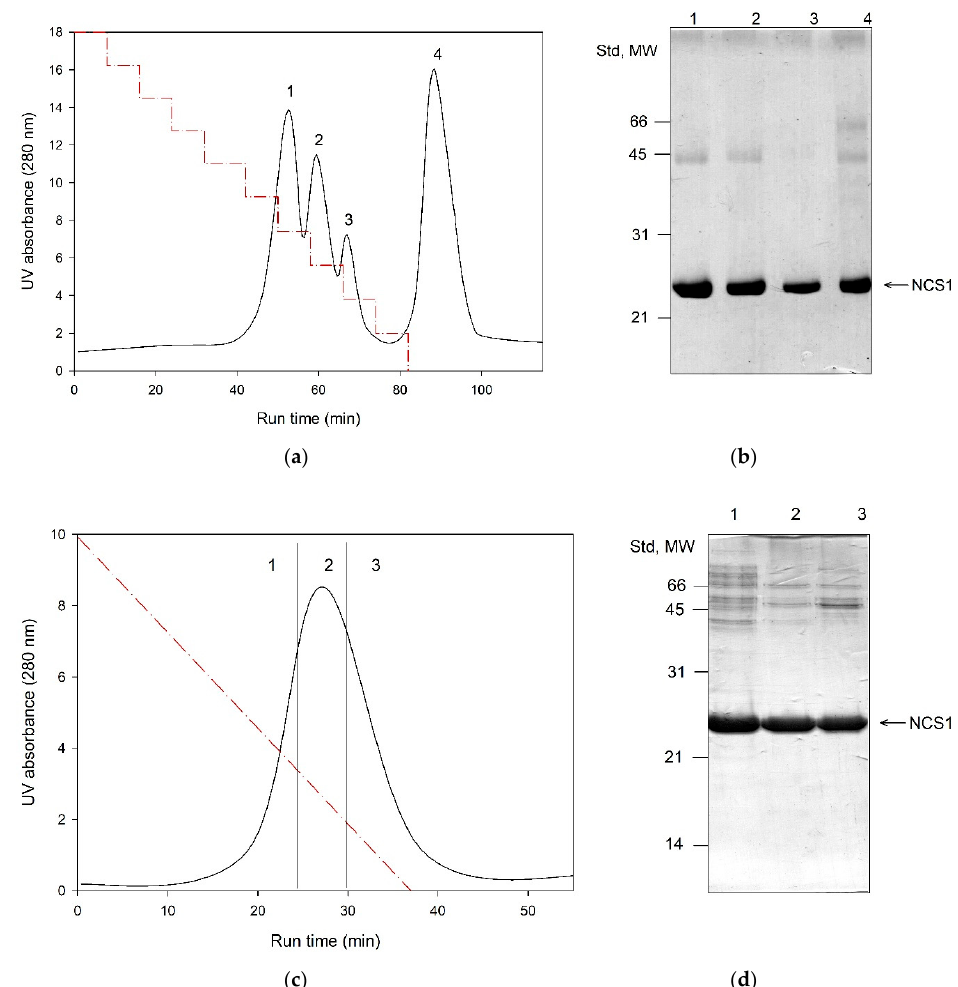
Figure 5. Final separation of myristoylated form of NCS-1 using hydrophobic interaction chromatography on Butyl Sepharose. ( a ) Representative chromatographic profiles obtained using linear gradient of NaCl. The numbers 1–4 denote fractions obtained under the following conditions: 800–600 mM NaCl, 2 mM MgCl 2 and pH 8.0 ( 1 ); 600–300 mM NaCl, 2 mM MgCl 2 and pH 8.0 ( 2 ), 300–100 mM NaCl, 2 mM MgCl 2 and pH 8.0 ( 3 ); 100–0 mM NaCl, 2 mM MgCl 2 and pH 8.0 ( 4 ). ( b ) Representative chromatographic profiles obtained using step gradient of NaCl. The numbers 5–8 denote fractions obtained under the following conditions: 400 mM NaCl, 2 mM MgCl 2 and pH 8.0 ( 5 ); 300 mM NaCl, 2 mM MgCl 2 and pH 8.0 ( 6 ), 200 mM NaCl, 2 mM MgCl 2 and pH 8.0 ( 7 ); 2 mM MgCl 2 and pH 8.0 ( 8 ). ( c,d ) SDS-PAGE of the fractions 1 – 4 ( c ) and 5 – 8 ( d ). The positions of molecular weight standards (in kDa) are denoted in the left-hand columns. The content of myristoylated NCS-1 contained in each fraction is indicated in Table 2.